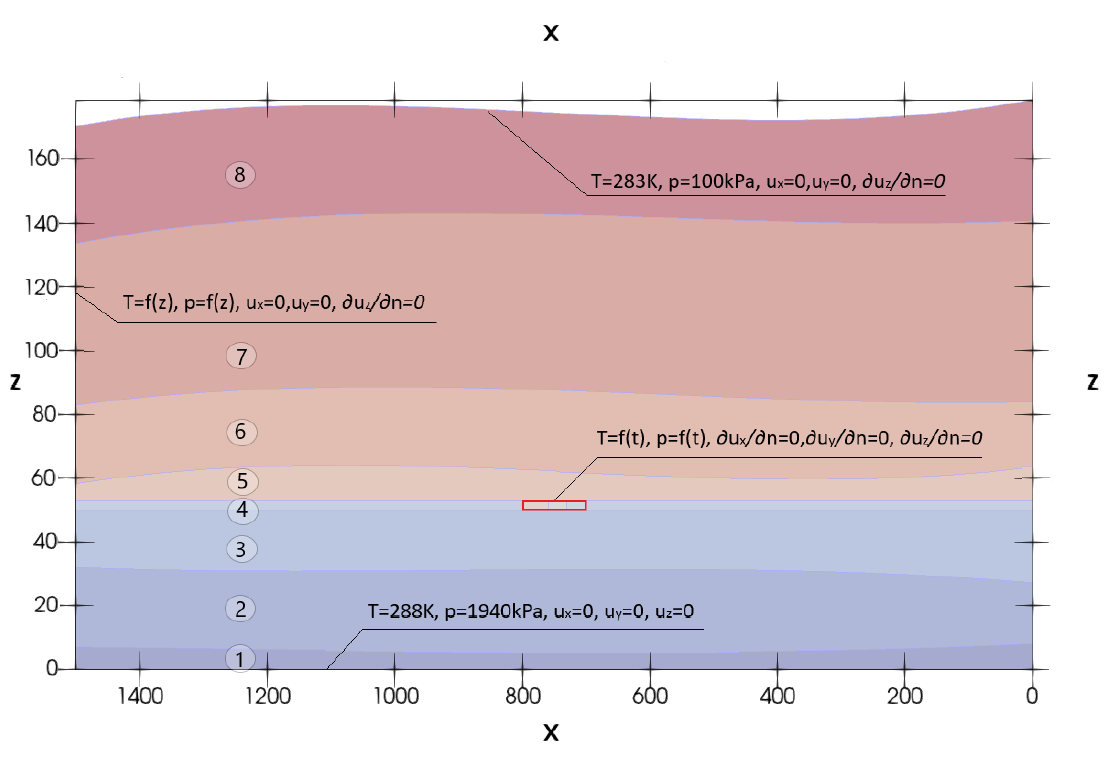
Figure 4: Main boundary conditions on cross-section, (non-uniform scale, aspect ratio5:1). Geological layers: 1. sandstone, 2. clayey pebble, 3. clay, 4. lignite (UCG generator is located in this layer), 5. clay, 6. clayey sand, 7. clay, 8. silty